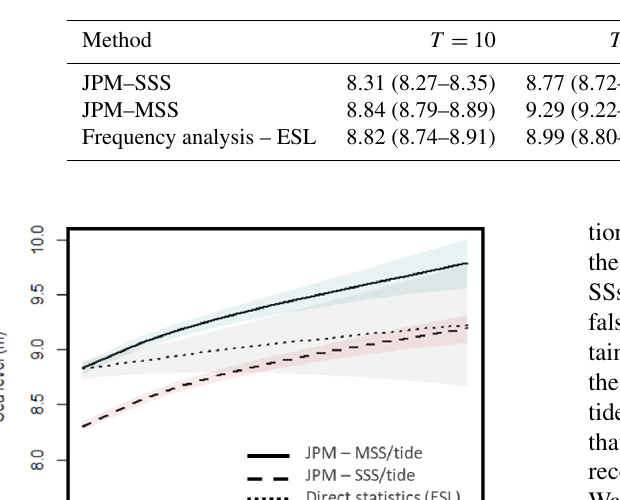
Table 3. Sea RLs and 95% confidence intervals for the three fitting procedures (in meters).